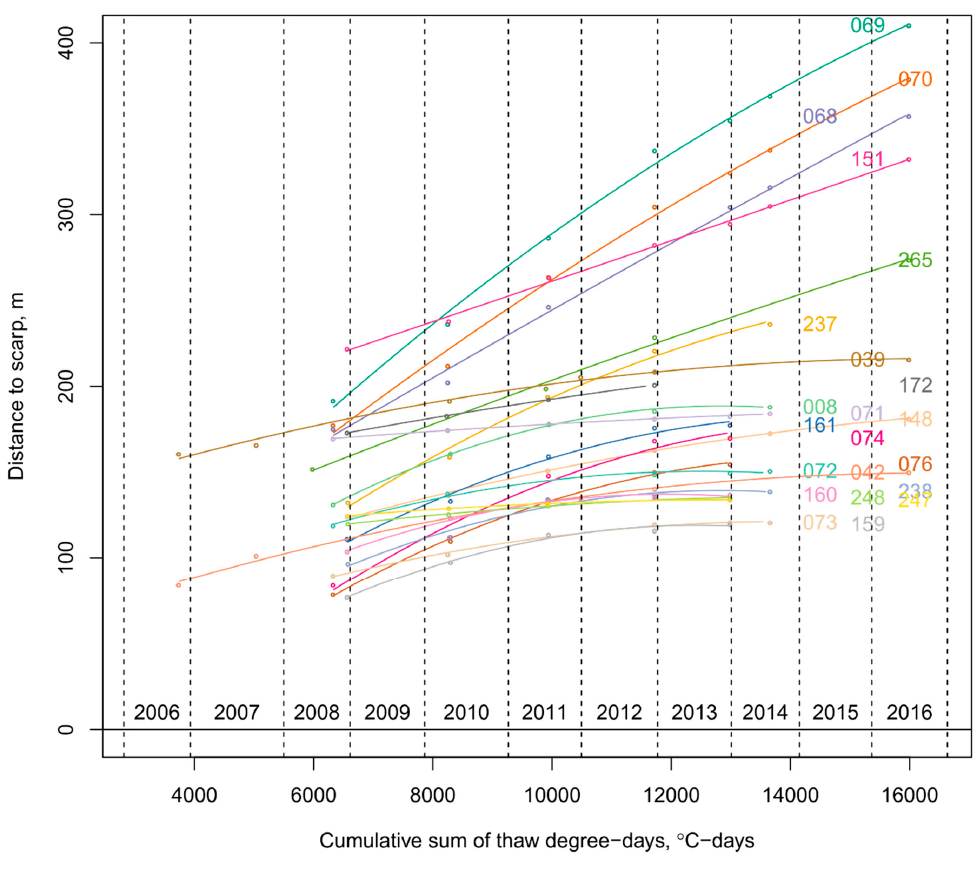
Figure 8. Scarp position along the centerline vs. cumulative TDDs. TDDs were measured at the Noatak RAWS and accumulated from an arbitrary start date of 1 January 2004. The vertical dashed lines mark winters (when TDD did not accumulate for multiple months), and the intervening thaw-season years are labeled. Curves are quadratic with regression coefficients in Table S7. The 3-digit numbers, coded by color, identify the slumps (Figure 2).